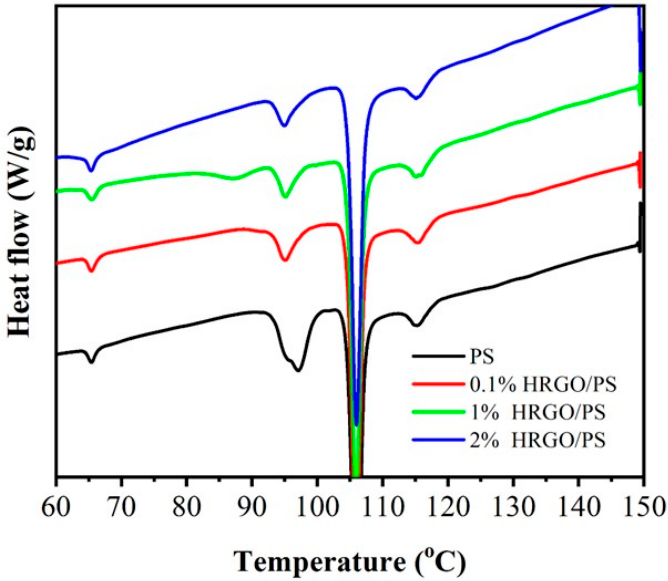
Figure 5. Differential scanning calorimetry (DSC) curves of 0.1% HRGO/PS, 1% HRGO/PS, and 2% HRGO/PS nanocomposites.